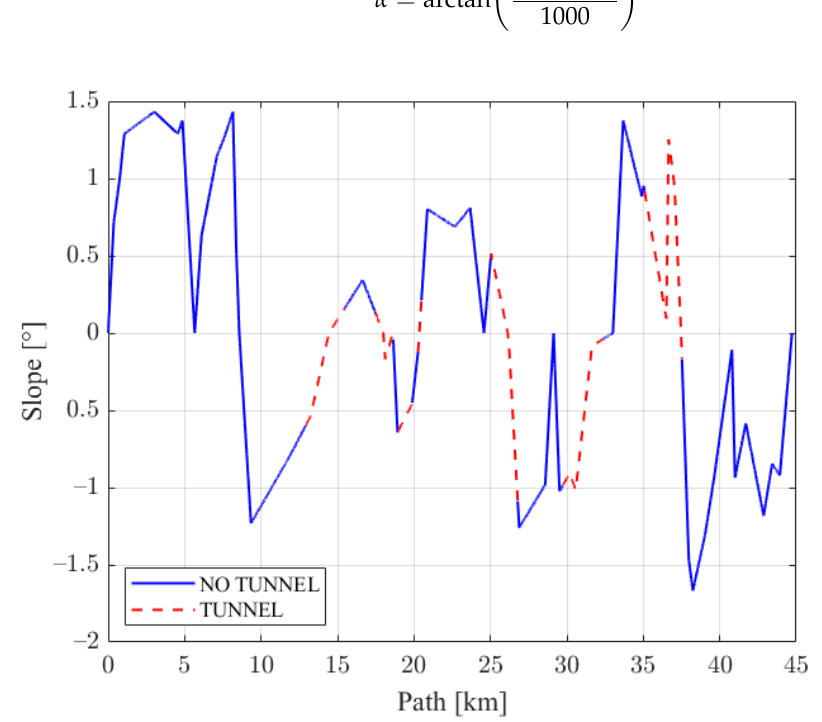
Figure 7. Slope, α , of the route as a function of the space travelled. Blue lines show no-tunnel sections, red dotted lines indicate tunnel sections.